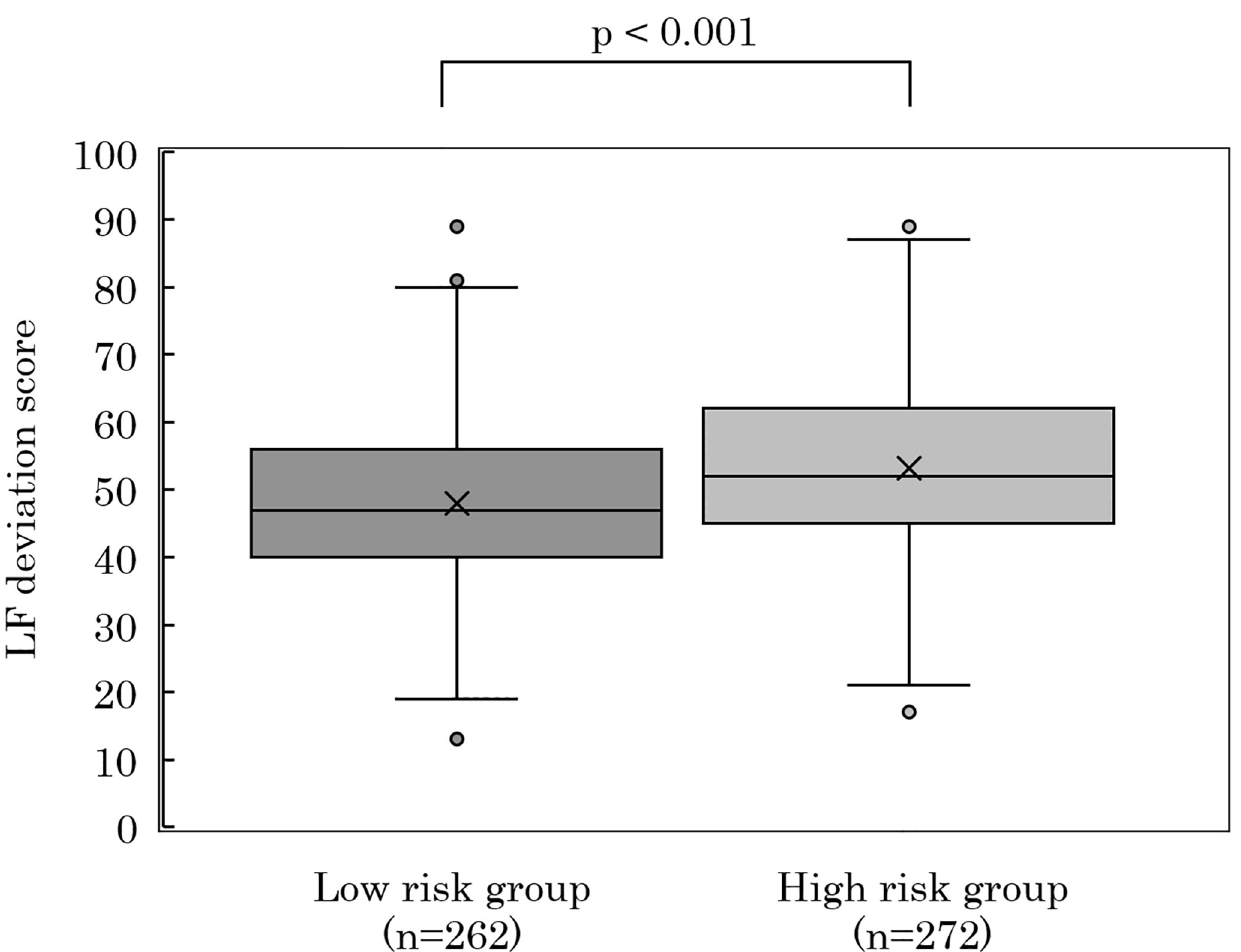
Fig 4. LF deviation scores (post-shift on the previous day) for high- and low-risk groups. Participants divided into high-risk and low-risk groups from the median daily collision risk index R 1hr . Comparison of LF deviation scores for high-risk and low-risk groups. T -test (Welch’s t -test) p -value is as